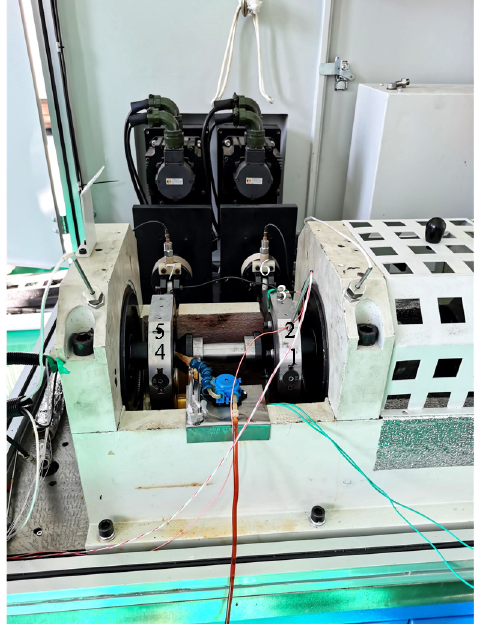
Figure 8. Physical diagram of the experimental station. 1 and 2—tested bearing and its outer ring fixture; 3—vibration sensor; 4 and 5—companion test bearing and its outer ring fixture; 6 and 7—loading system.